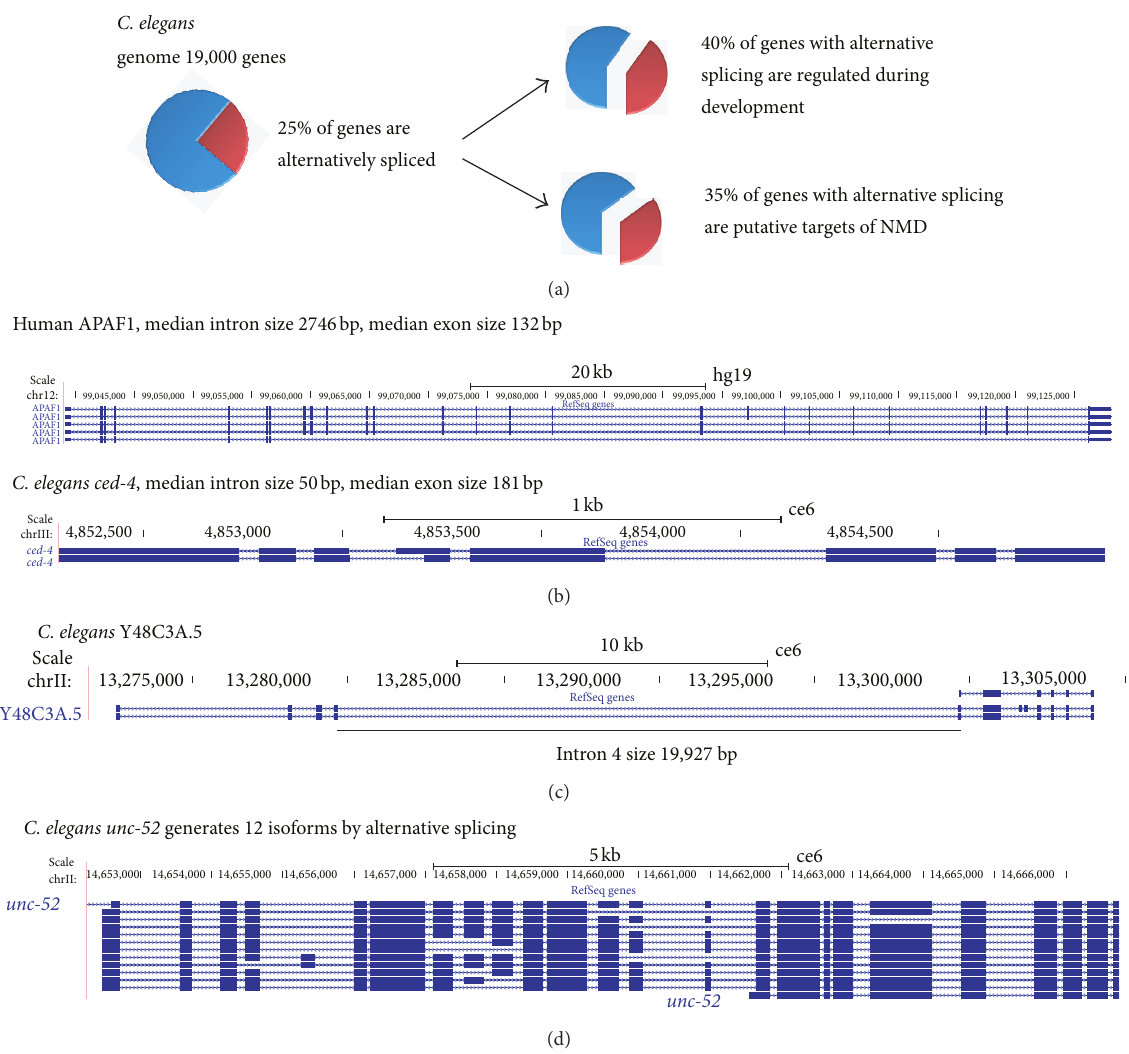
Figure 1: Caenorhabditis elegans alternative splicing events. (a) Genome-wide analysis of alternative splicing in C. elegans ; (b) comparison of the human APAF1 and the C. elegans homolog ced-4 gene models shows significant differences in intron size between species for genes with important alternative splicing events; (c) Y48C3A.5 intron 4 (19,927bp) is one example of the 144 introns in the C. elegans genome that are more than 10kb in length; (d) C. elegans unc-52 gene undergoes complex alternative splicing that generates at least 12 different isoforms by the use of nine different cassette